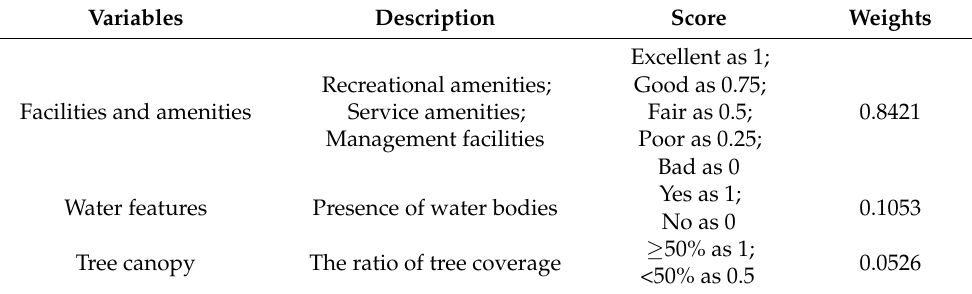
Table 1. Variables of the park quality